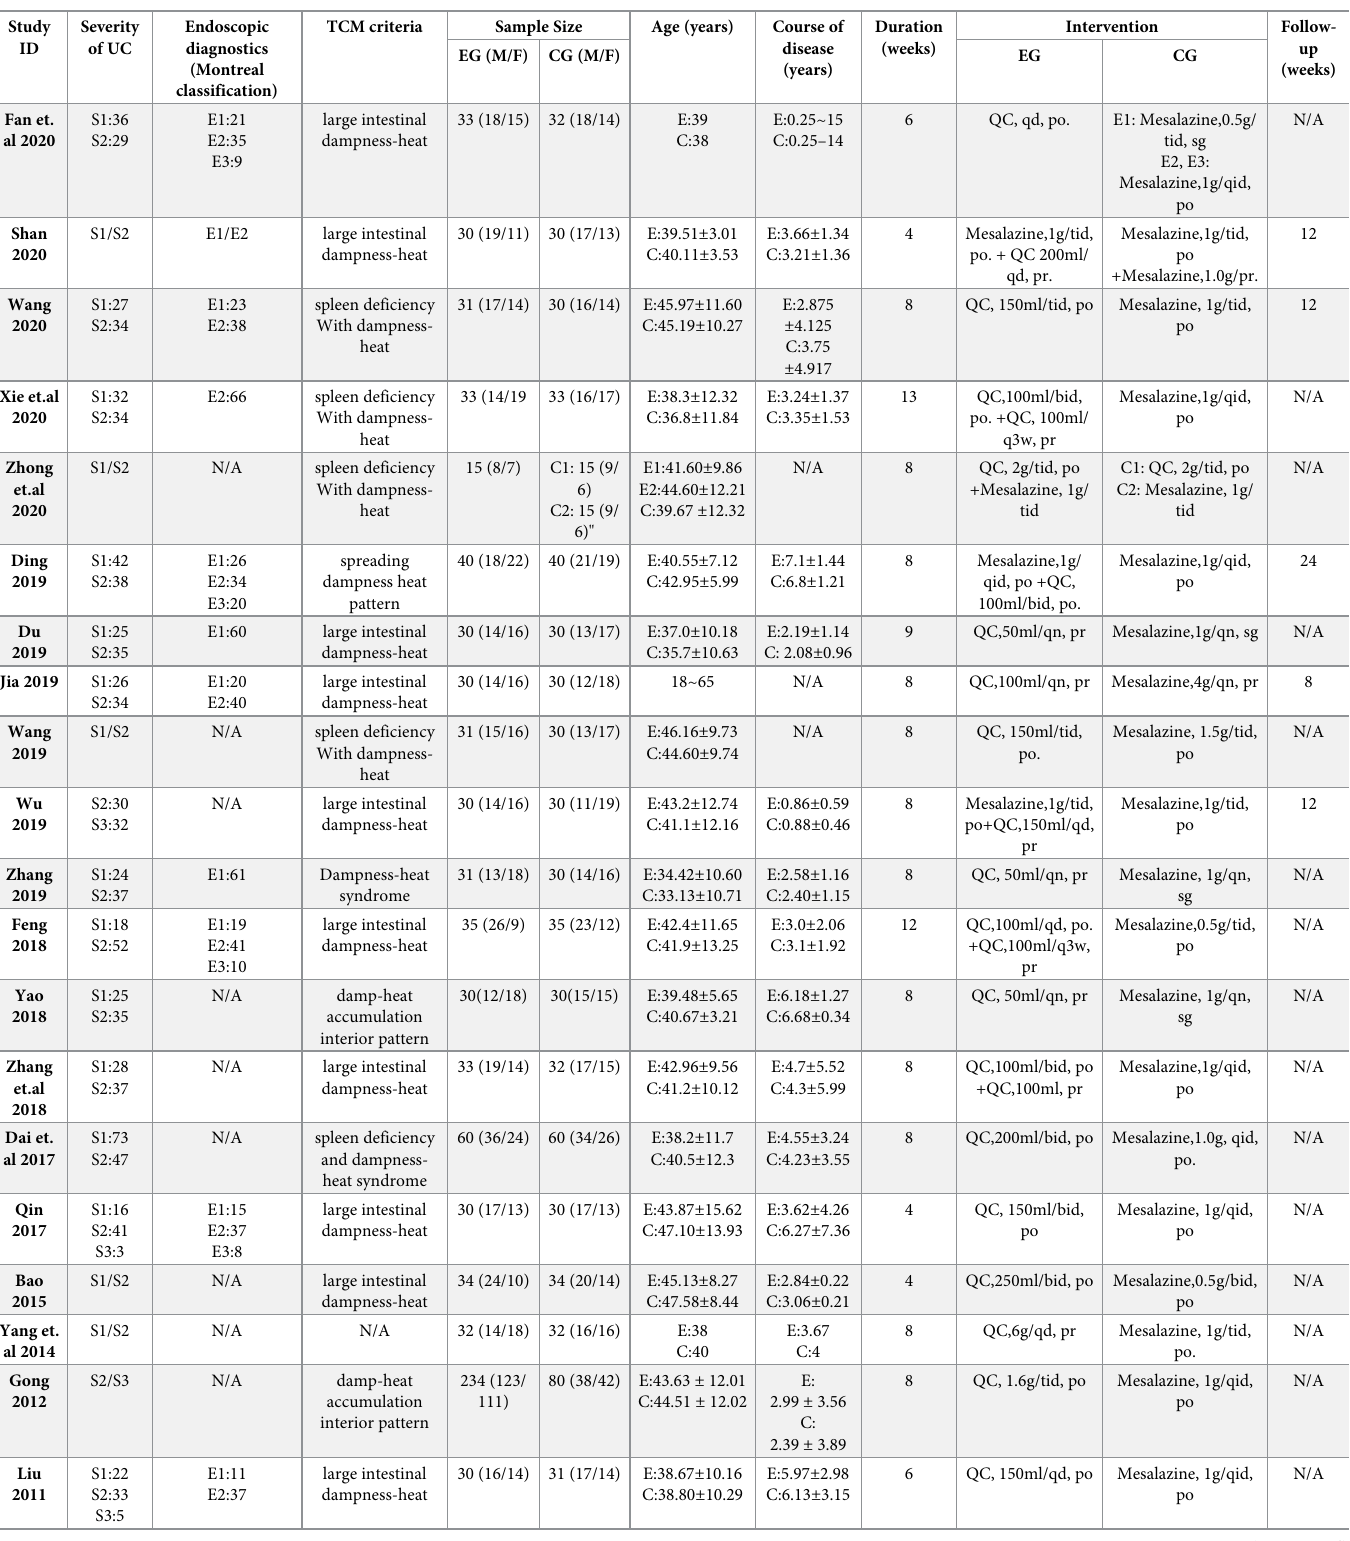
Table 1. Characteristics of the studies